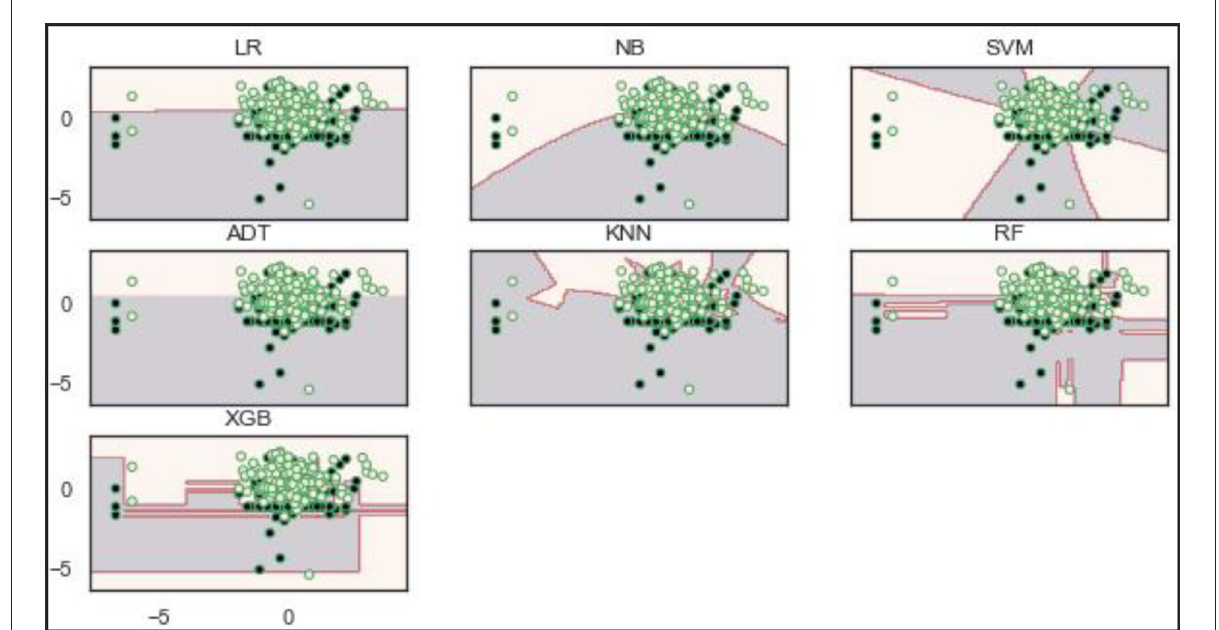
FIGURE11 Decision boundaries of the models on the original dataset.